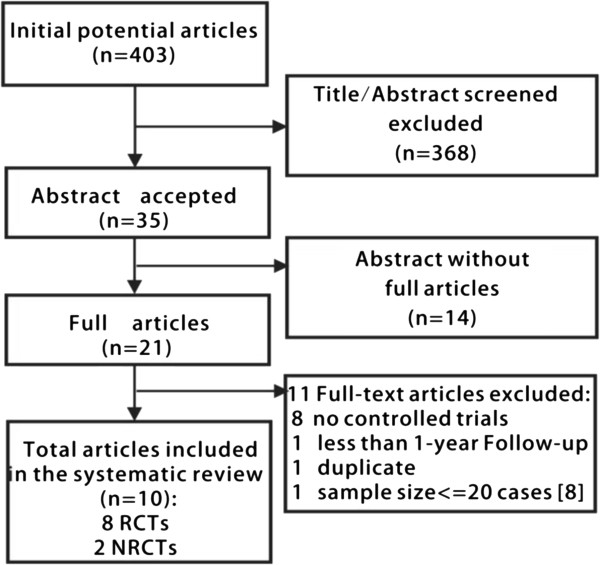
Process of study selection. The excluded 11 articles include eight articles without controlled trials, one article’s patients follow-up less than one year ,one article’s sample size <=20 cases and two articles from a single author appeared to include duplication of patients, only the study with the largest patient group was included and the other one was excluded.